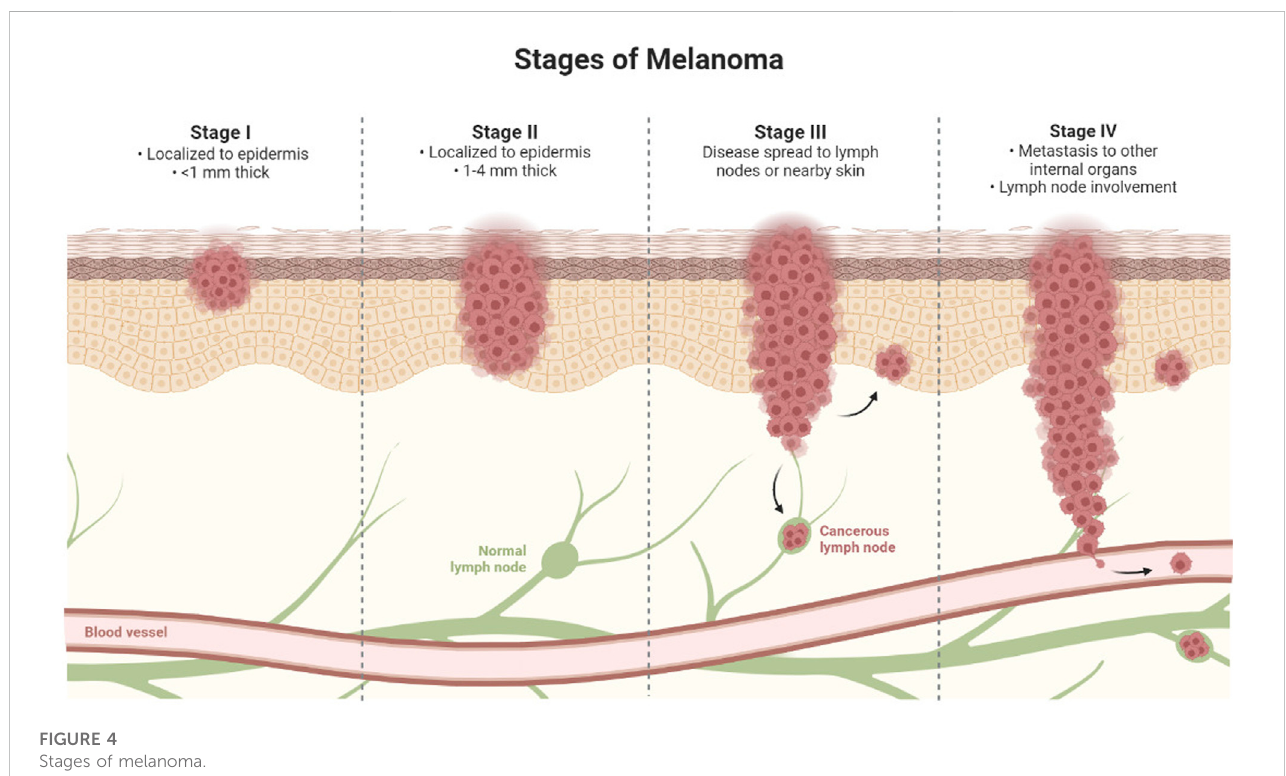
FIGURE 4 Stages of